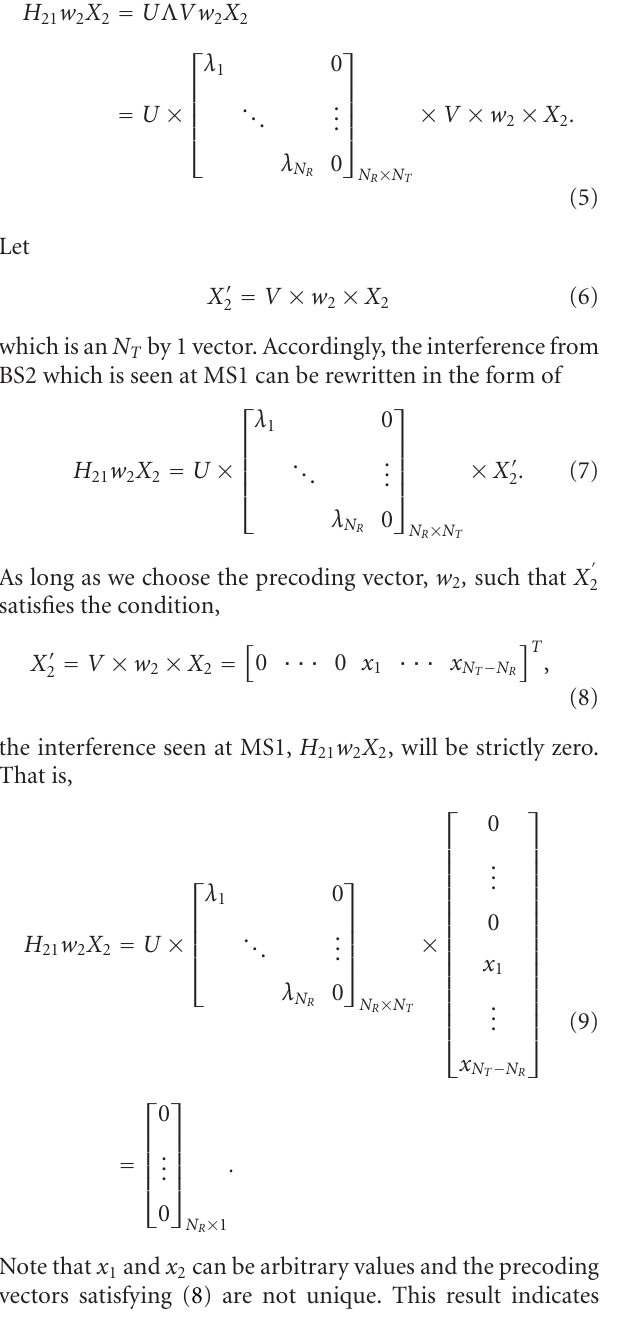
Figure 1: System model of two interfering cell-edge